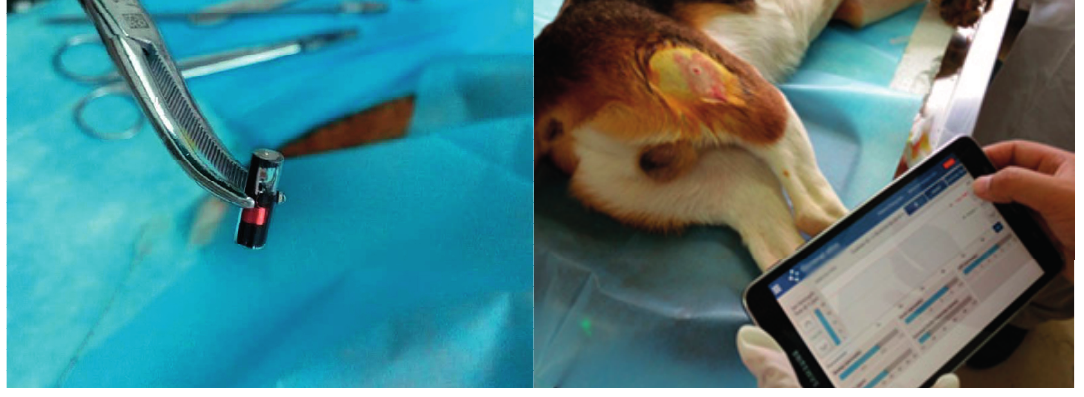
Figure 9. Animal model (dog) for a mini-stimulator (NuStim) without batteries for nerve and muscle stimulation in in Beijing.